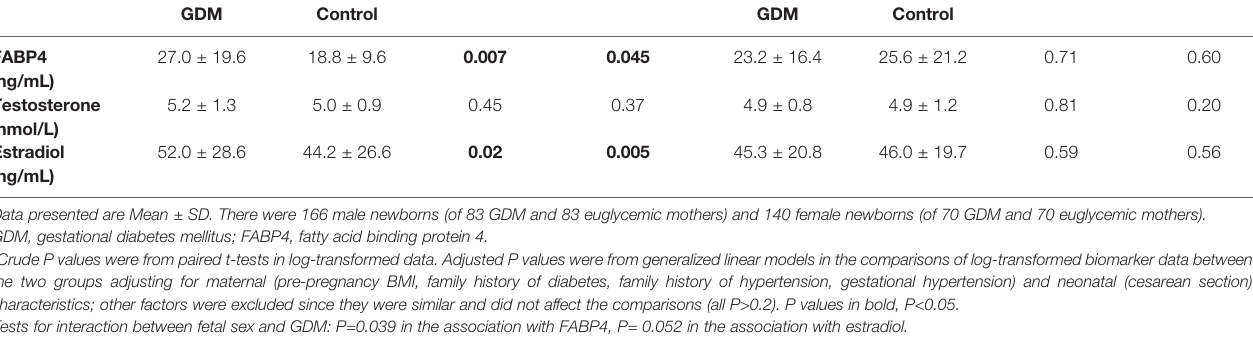
TABLE 2 | Cord plasma FABP4, testosterone and estradiol concentrations in the newborns of GDM vs . euglycemic (control) mothers strati fi ed by infant sex. Male newborns Crude P* Adjusted P* Female newborns Crude P*